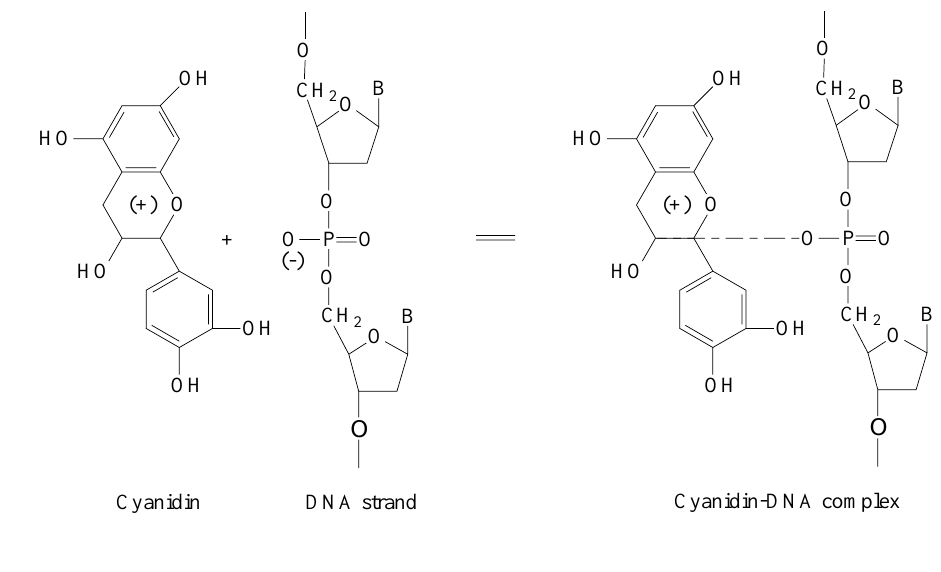
Figure 5. Proposed mechanism for cyanidin–DNA interation which leads to the formation of cyanidin–DNA copigmentation complex